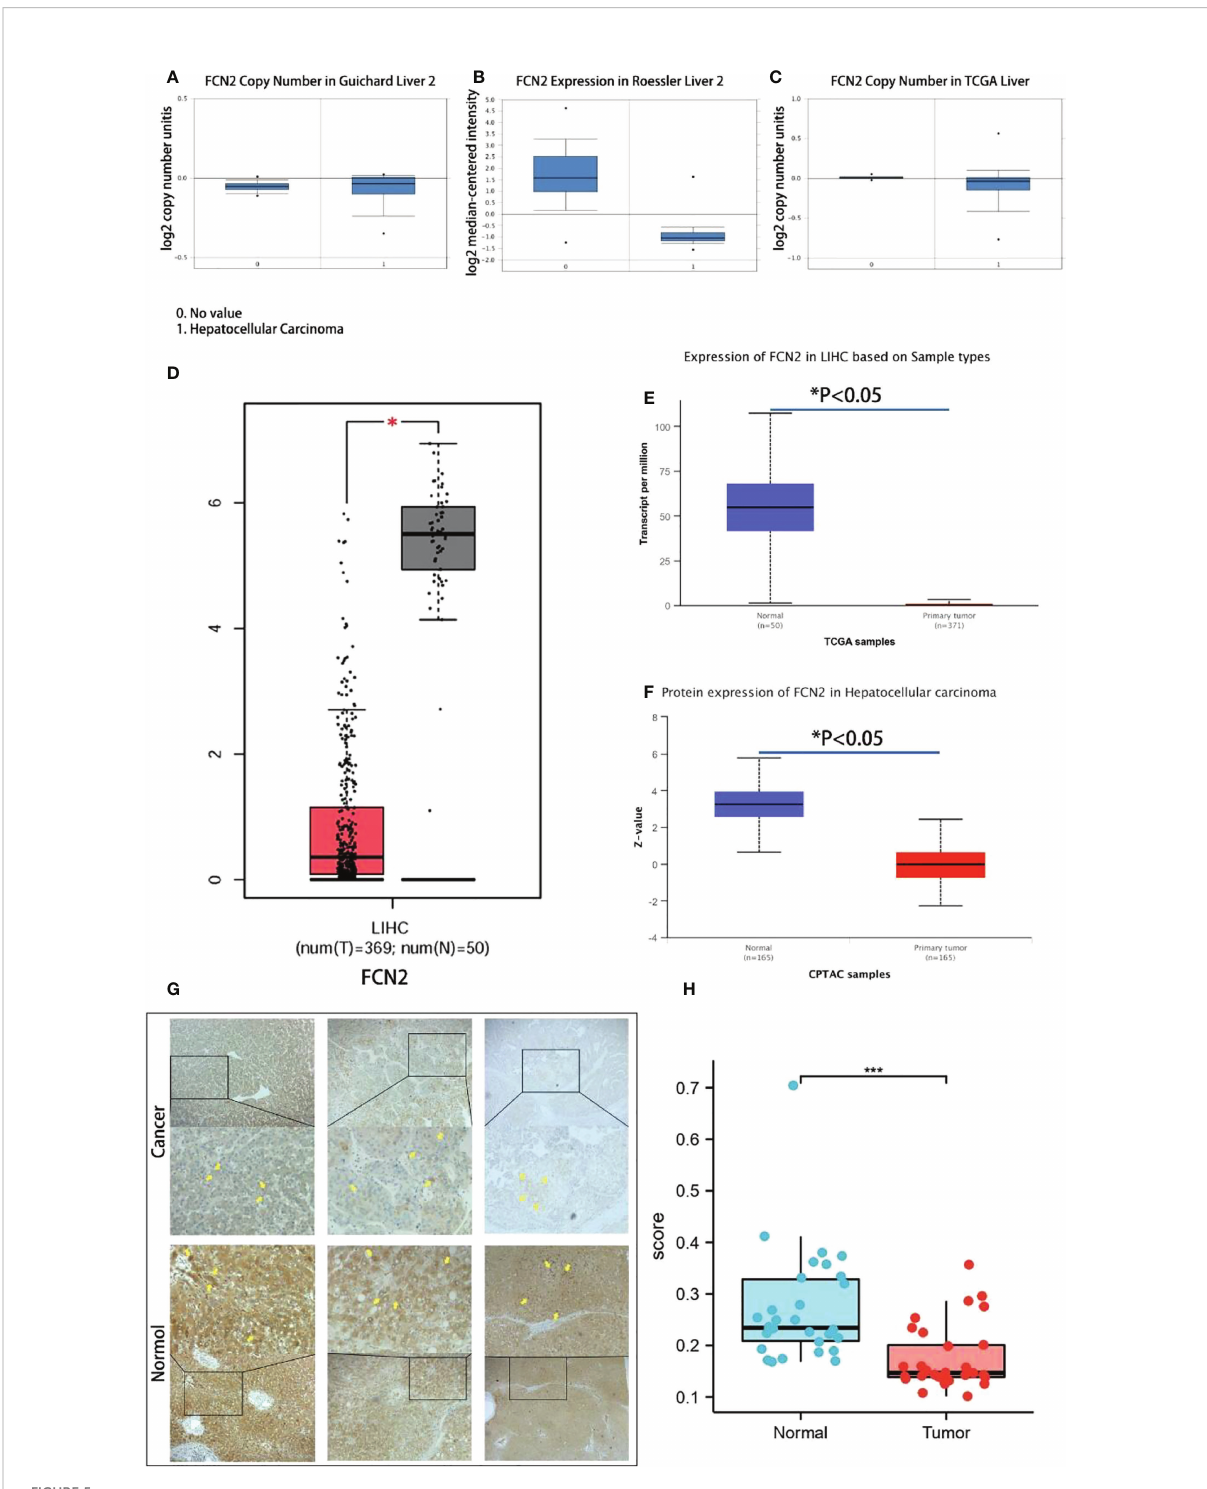
FIGURE 5 Transcription levels of FCN2 in liver cancer and normal tissues. (A – C) Expression differences of the FCN2 gene between liver cancer tissues and normal tissues in the Oncomine database. (D) FCN2 mRNA expression in liver cancer tissue and normal tissue based on the GEPIA2 database (TCGA tumors vs . TCGA normal). (E, F) FCN2 protein expression in hepatocellular carcinoma in the UALCAN database. (G) Part of the results of the immunohistochemistry experiments. (H) Average optical density of liver cancer tissues and adjacent tissues from 30 liver cancer patients. TCGA , The Cancer Genome Atlas. * p < 0.05, *** p <